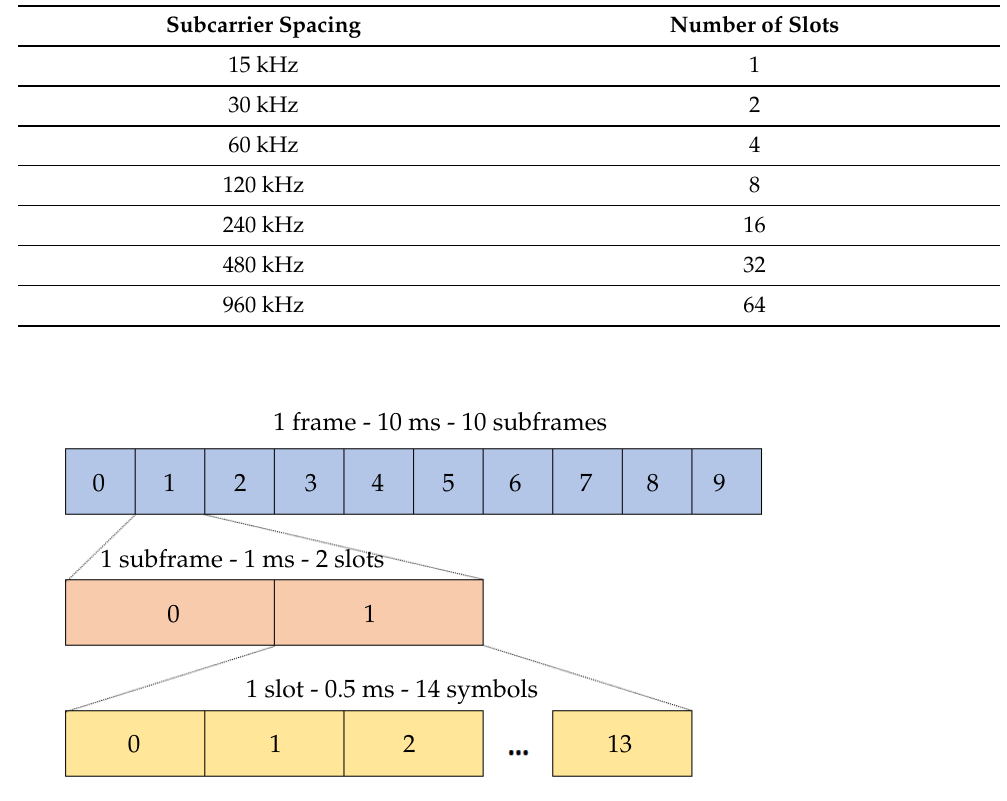
Table 1. Number of slots per subframe.